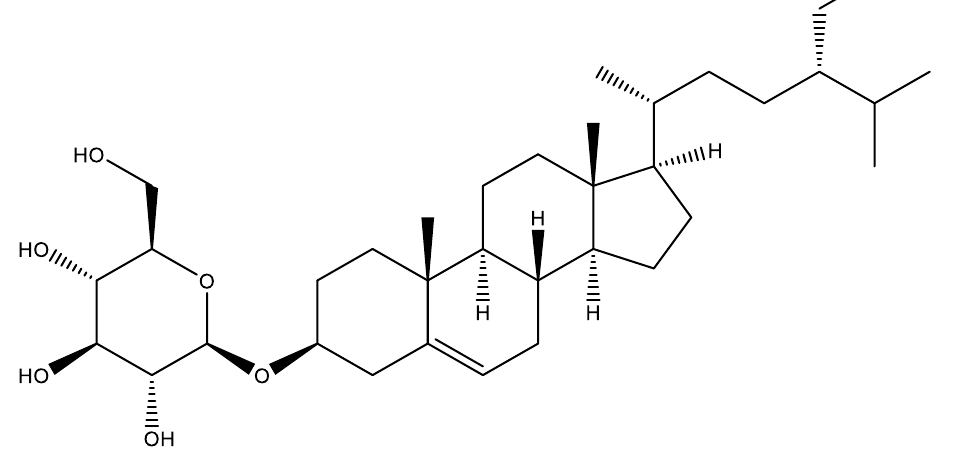
Figure 1. Chemical structure of